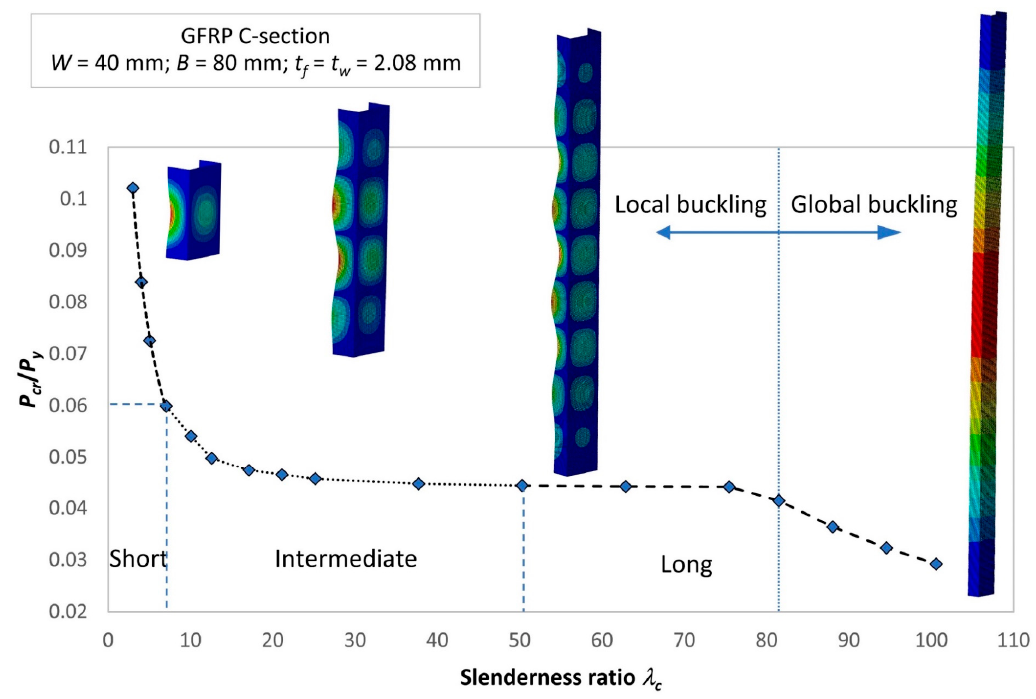
Figure 14. Design curve for the GFRP channel section column.